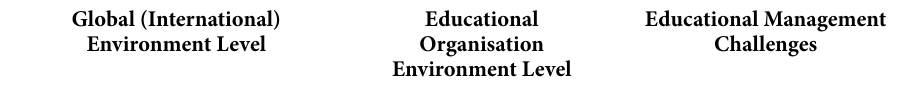
Table 1. Essential challenges constituting the strategic context for the educational